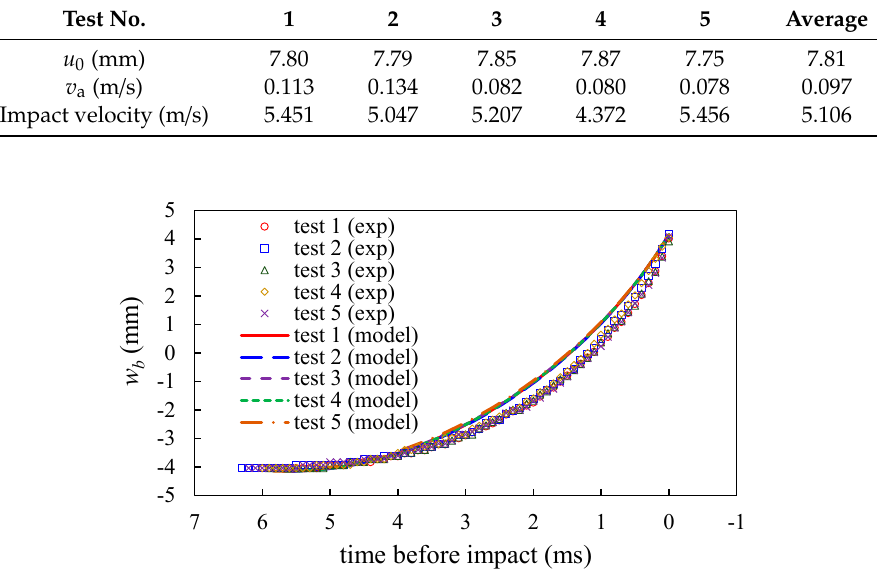
Figure 9. The comparisons of the deflection w b of the beam tip before impact obtained by experiments and model.